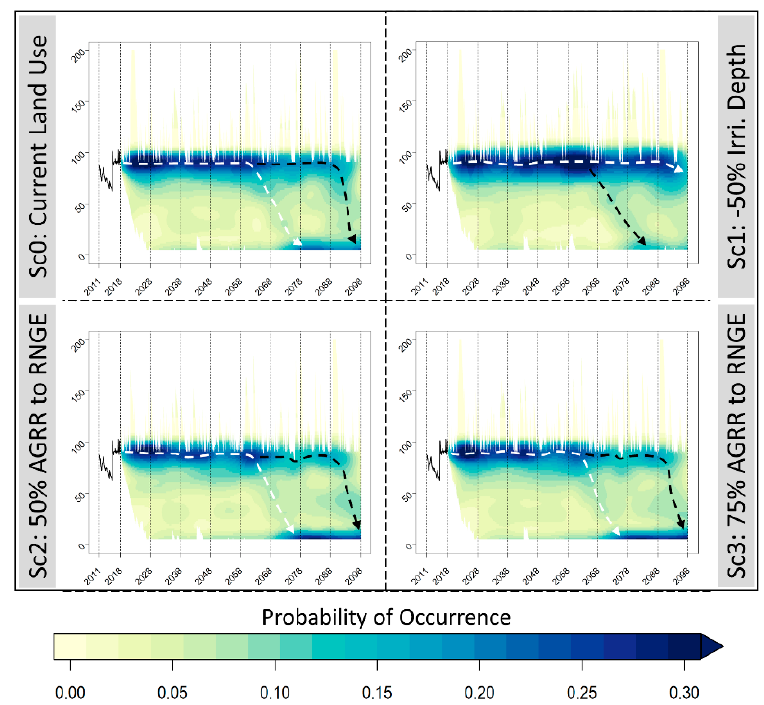
Figure 8. Reservoir storage (m 3 × 10 6 ) for the baseline (Sc0) and three integrated climate and land use scenarios (Sc1–Sc3). Primary paths (white dotted lines) represent clearly defined continuous pathways that incorporate likely to most likely events, while secondary paths (black dotted lines) describe likely to less likely alternative pathways.